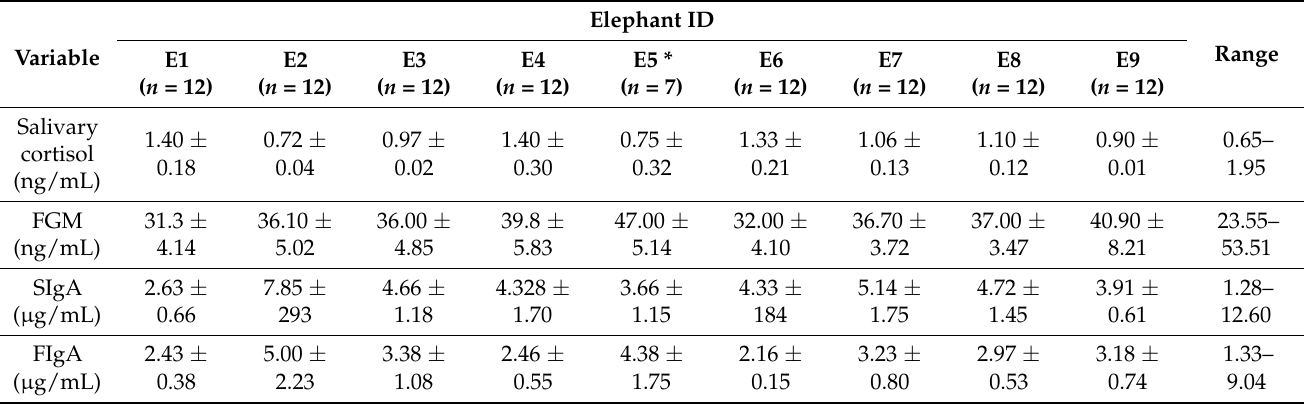
Table 5. Overall mean ( ± SEM) concentrations of salivary cortisol, fecal glucocorticoid metabolites (FGM), salivary IgA (SIgA), and fecal IgA (FIgA) in individual elephants in the study.